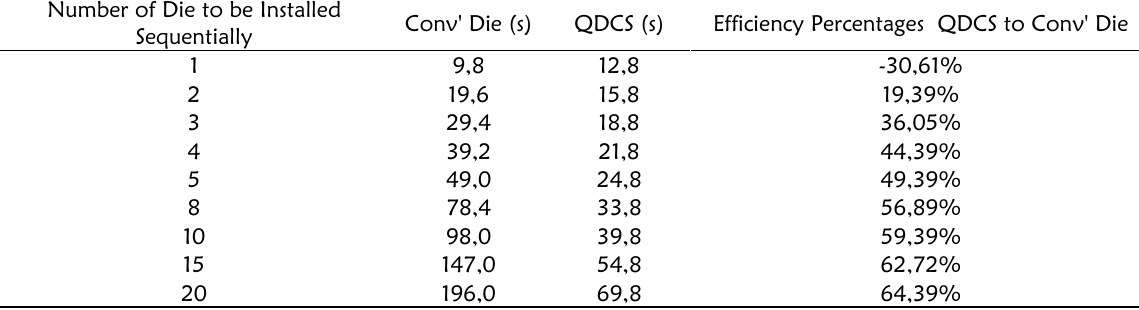
Table 2: Efficiencies